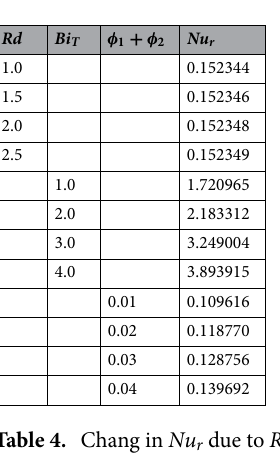
Table 4. Chang in Nu r due to Rd , Bi T and φ 1 + φ 2 .